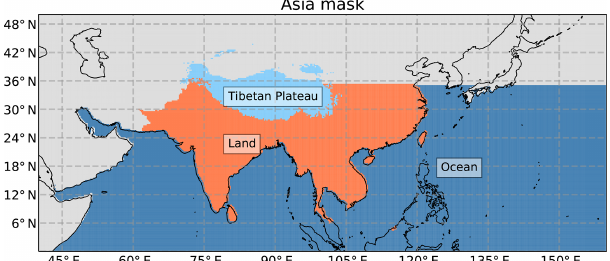
Figure 11. Mask of the three defined regions that partition